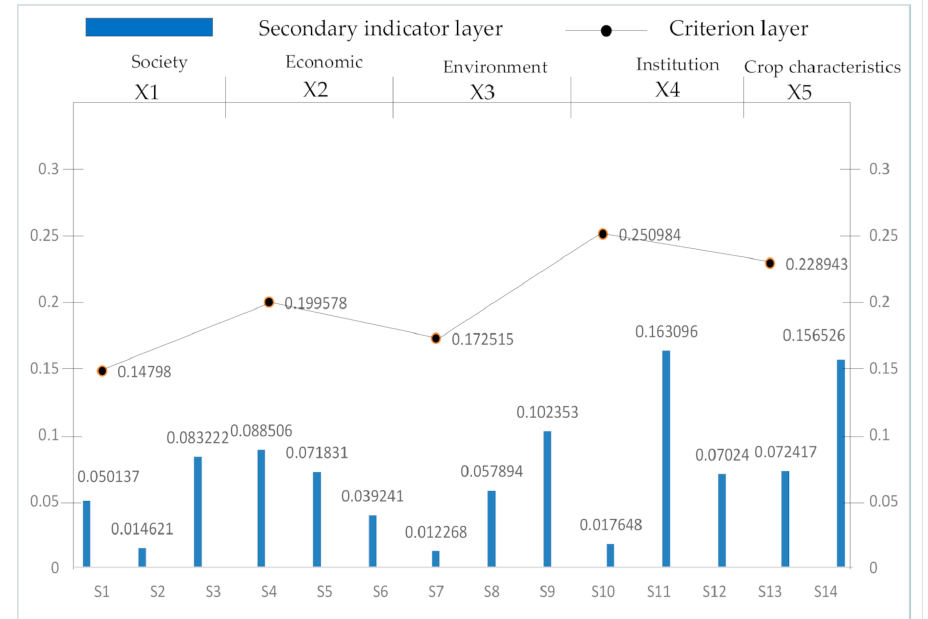
Figure 7. The total weight of factors of agricultural supply chain resilience to water.